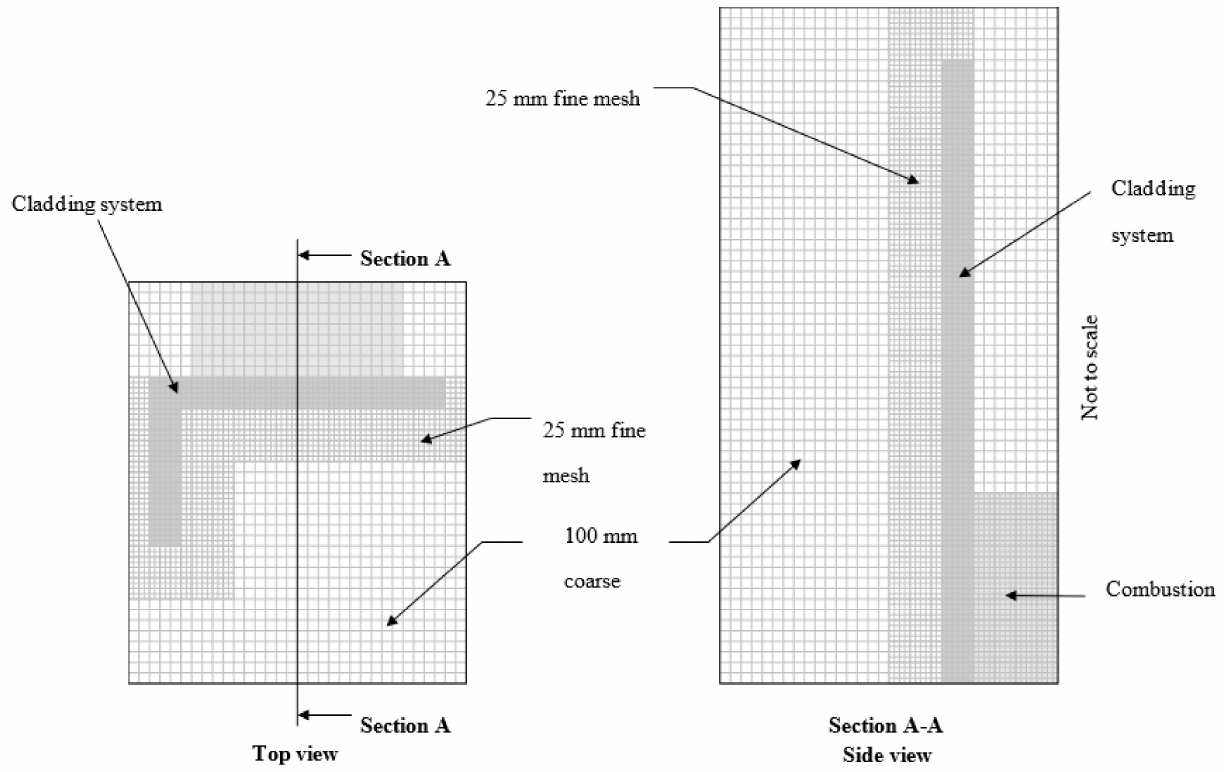
Figure 5. Optimised mesh approach for modelling—indicative